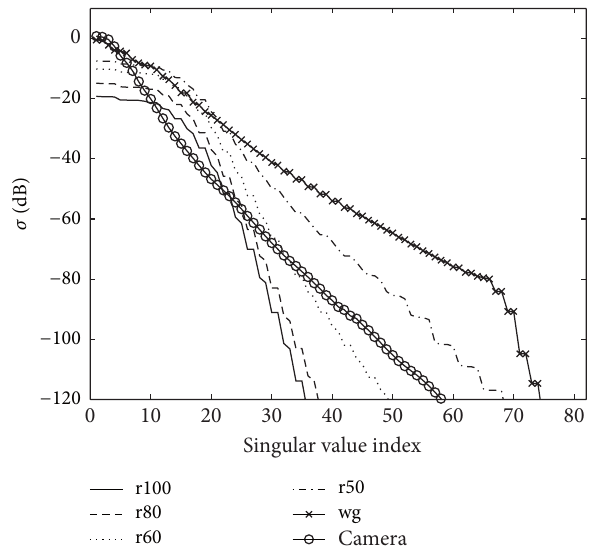
Figure 4: Singular values of the G 𝑜 operator for the different con- figurations. For the circular case, index r 𝑥 refers to a measurement system radius of 𝑥 mm. wg refers to the waveguide